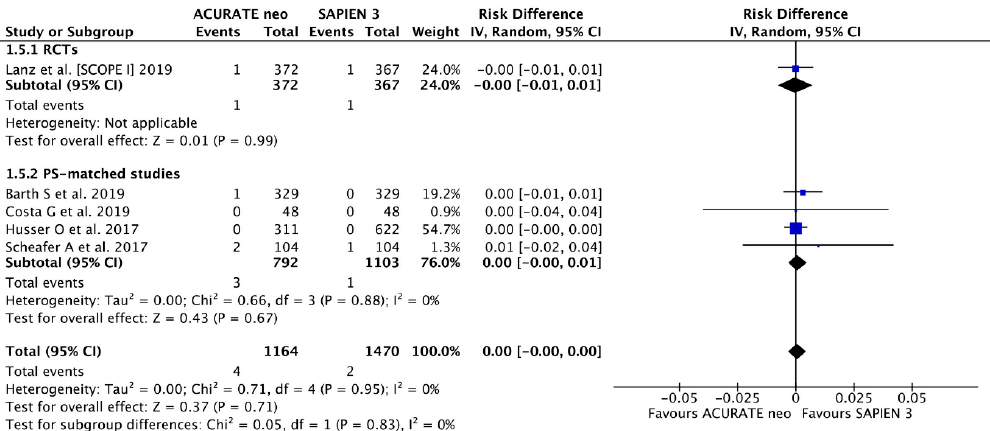
Figure A7. Clinical outcomes. Individual and summary risk ratios with corresponding 95% confidence intervals for the comparison of ACURATE neo and SAPIEN 3 in the analysis of periprocedural myocardial infarction.